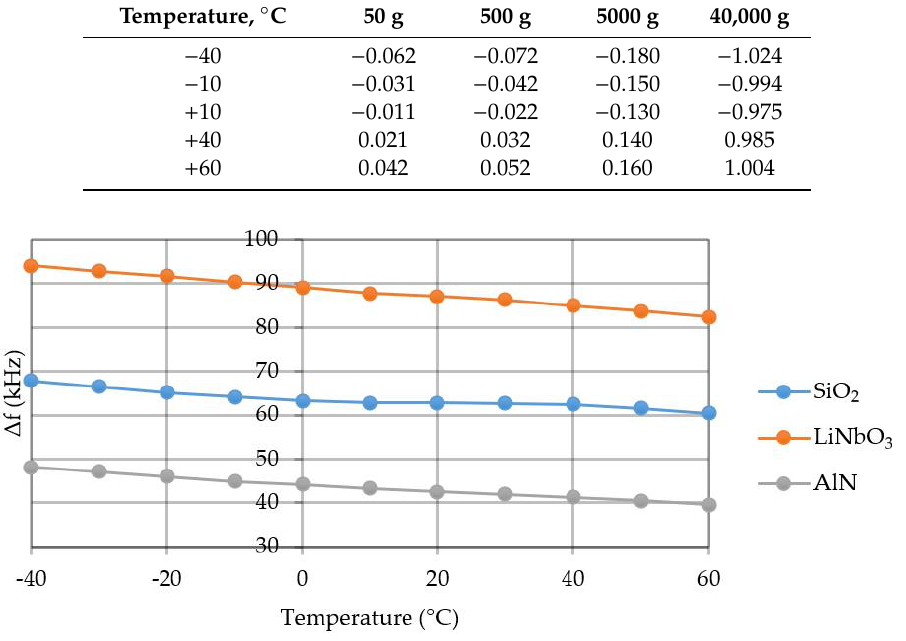
Table 4. Deformation of the console when heating or cooling and acceleration ( µ m).